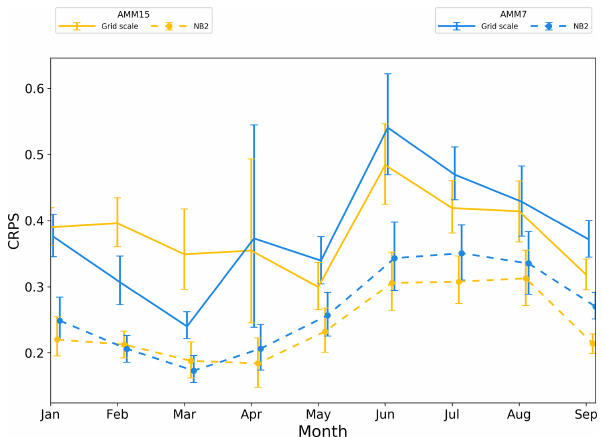
Figure 13. On-shelf monthly time series of CRPS. Error bars rep- resent 95% confidence values obtained from 10000 samples using bootstrap with replacement.